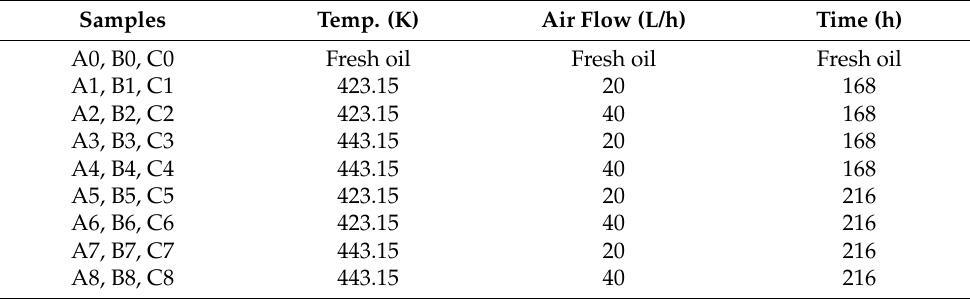
Table 2. Samples used in the different ageing